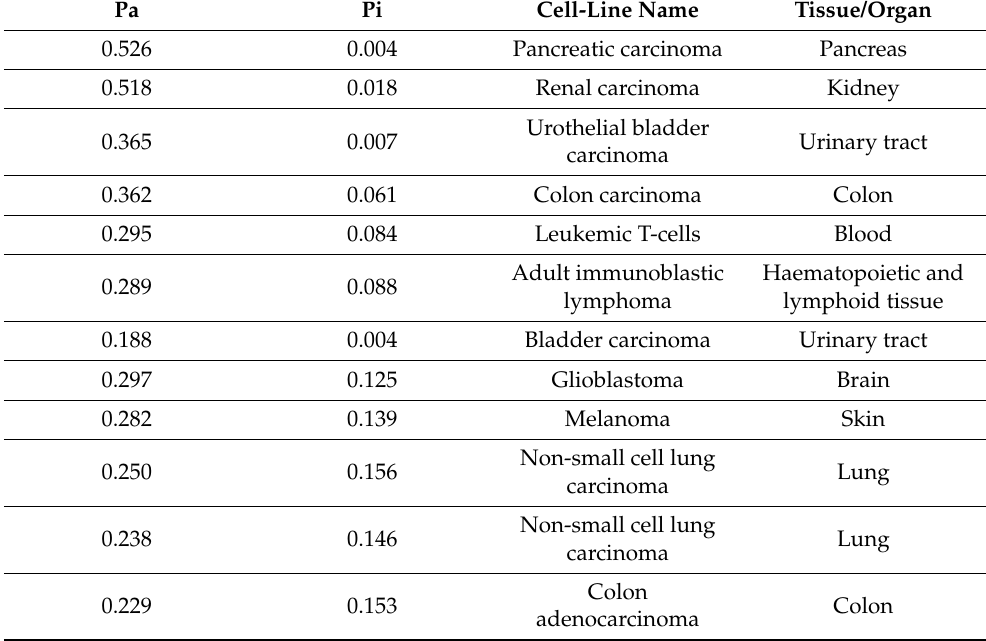
Table 2. Cancer cell line prediction results of